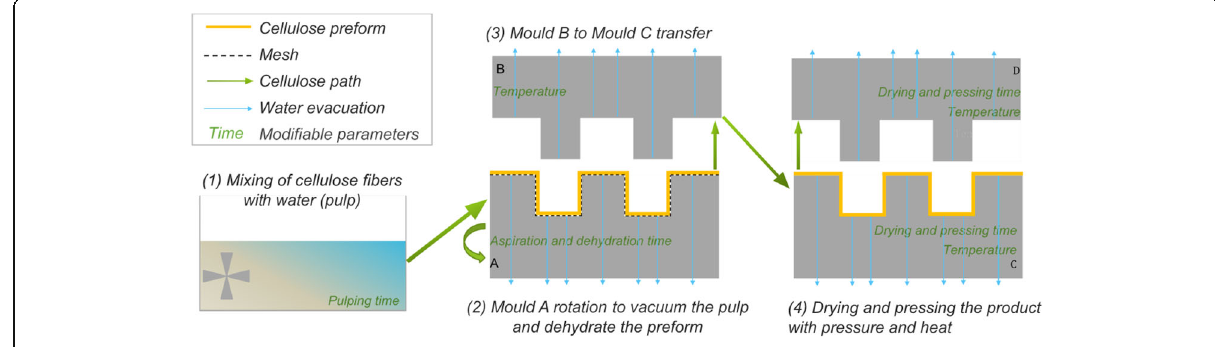
Fig. 1 Diagram of the manufacturing process of molded pulp products